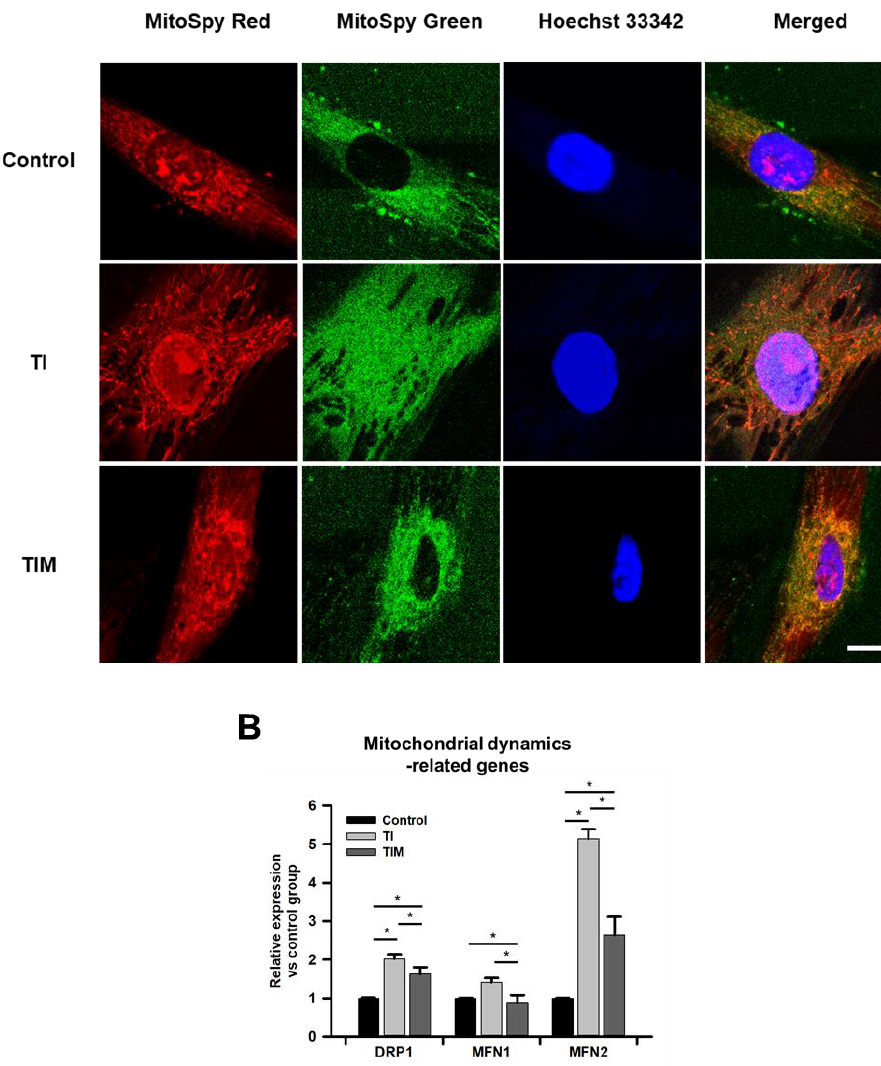
Figure 2. MIT-001 ameliorated mitochondrial function in hPD-MSCs. ( A ) Representative images of control, TNF- α /IFN- γ -exposed, and TNF- α /IFN- γ with MIT-001-treated hPD-MSCs. The mitochondrial membrane potential (red), mitochondrial mass (green), and nuclei (blue) of hPD-MSCs were stained and imaged using confocal microscopy. Scale bar, 20 µ m. ( B ) Expression of the mitochondrial dynamics-related genes DPR1, MFN1, and MFN2 was analyzed using real-time qPCR. C: control, TI: TNF-α + IFN-γ, TIM: TNF-α + IFN-γ + MIT-001. Data are presented as the mean ± SEM ( n = 3 for real-time qPCR data). Statistical significance was determined by a one-way ANOVA. * p < 0.05.